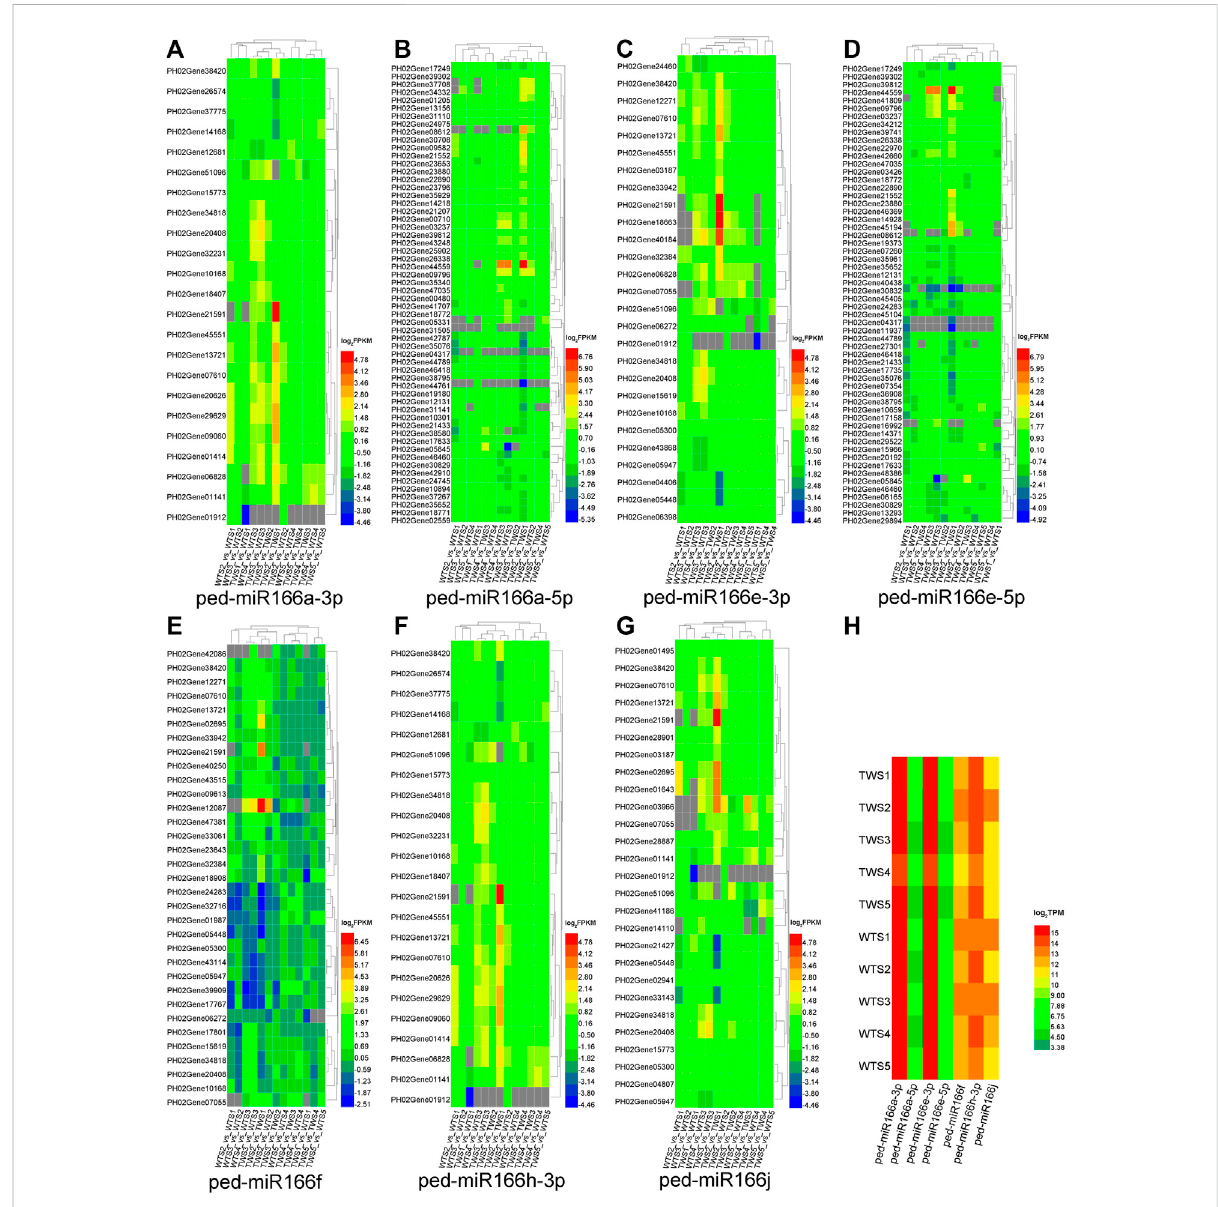
FIGURE 4 Expression patterns of seven miR166s and their target genes differentially expressed in 13 pairwise comparisons of the WT, TW, and WTTW groups. Both the wild-type (WT) and the thick-walled (TW) groups comprise four pairwise comparisons between two successive stages (WTS2/ TWS2_vs_WTS1/TWS1, WTS3/TWS3_vs_WTS2/TWS2, WTS4/TWS4_vs_WTS3/TWS3, and WTS5/TWS5_vs_WTS4/TWS4), and the WTTW group comprises fi ve pairwise comparisons between two stages (TWS1 – 5_vs_WTS1 – 5). (A – G) Expression patterns of the target genes of seven miR166s. (H) Expression patterns of seven miR166s. Gray squares indicate miRNAs and genes with low expression (TPM ≤ 1 or FPKM ≤